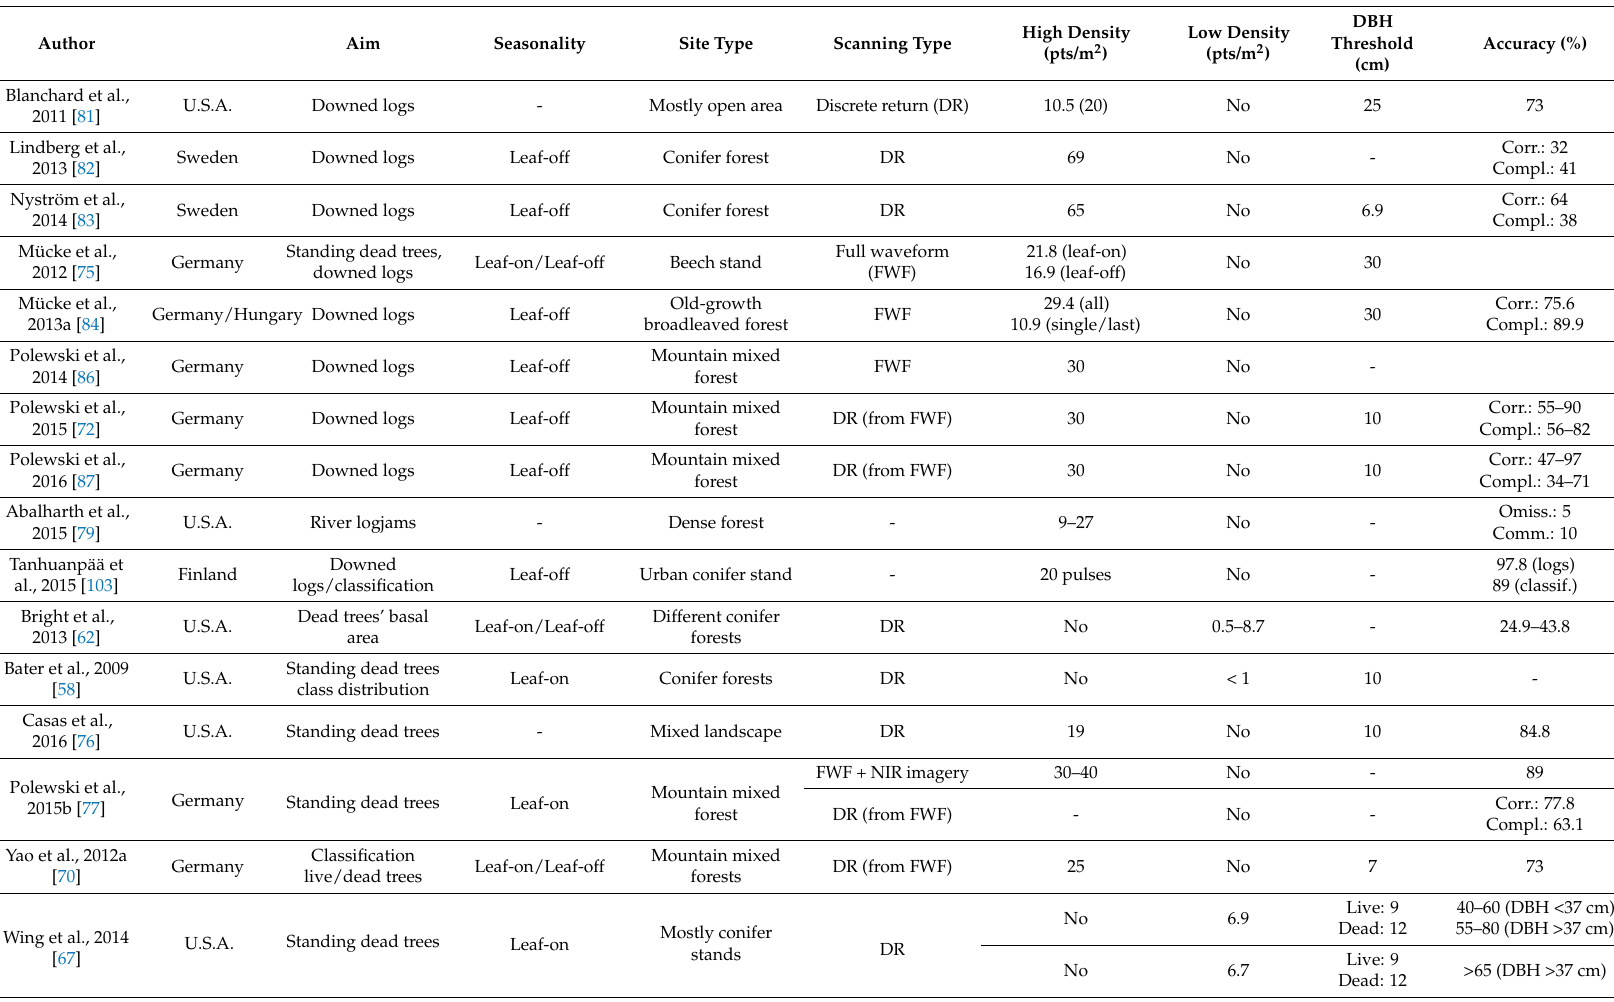
Table 1. Main studies related to deadwood (standing or lying) identification through Airborne Laser Scanning (ALS) data (Corr.: correcteness, Compl.: completeness, Omiss.: omission, Comm.: commission